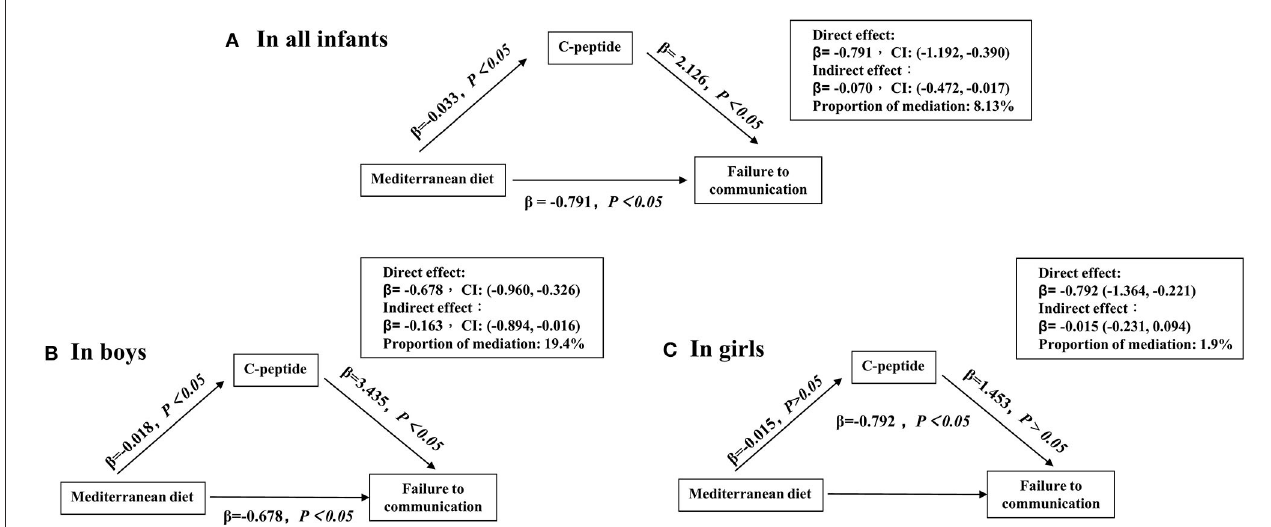
FIGURE3 Mediation effects of cord C-peptide (loge transformed) on the relationship between maternal Mediterranean diet score and failing the communication domain. (A–C) Adjusted confounders included maternal age, education, household income, pre-pregnancy BMI, gestational diabetes, blood pressure (systolic and diastolic), anemia during pregnancy, depressive symptoms, maternal physical exercise, the supplement of nutrients, such as vitamin D, folic acid, and iron, pregnancy history, delivery mode, gestational week, birth weight, and patterns of infant